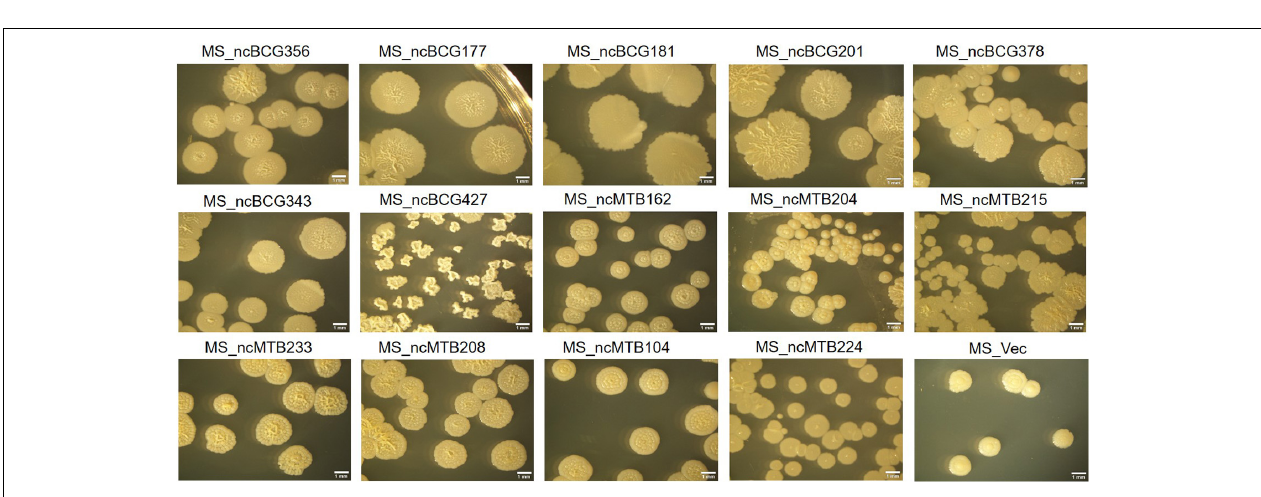
FIGURE 10 | Single-colony morphology of candidate sRNAs overexpressing Mycobacterium smegmatis MC 2 155.